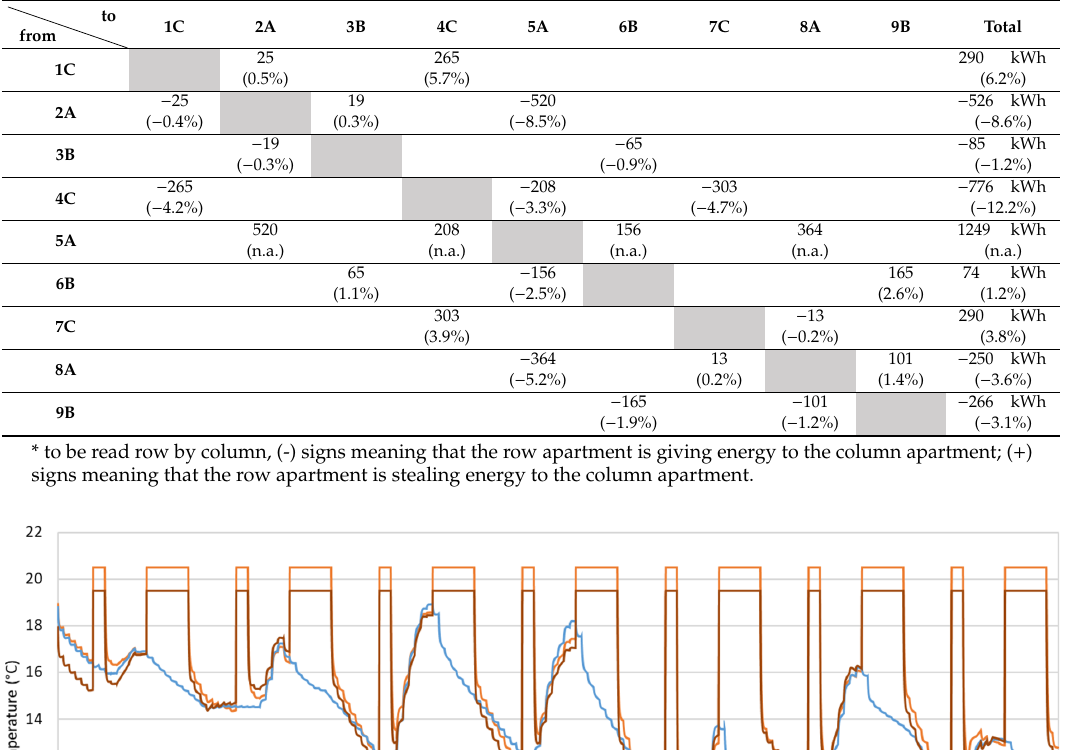
Table 6. Percentage* of heat given or stolen between adjacent apartments, scenario a, kWh and (%). to from